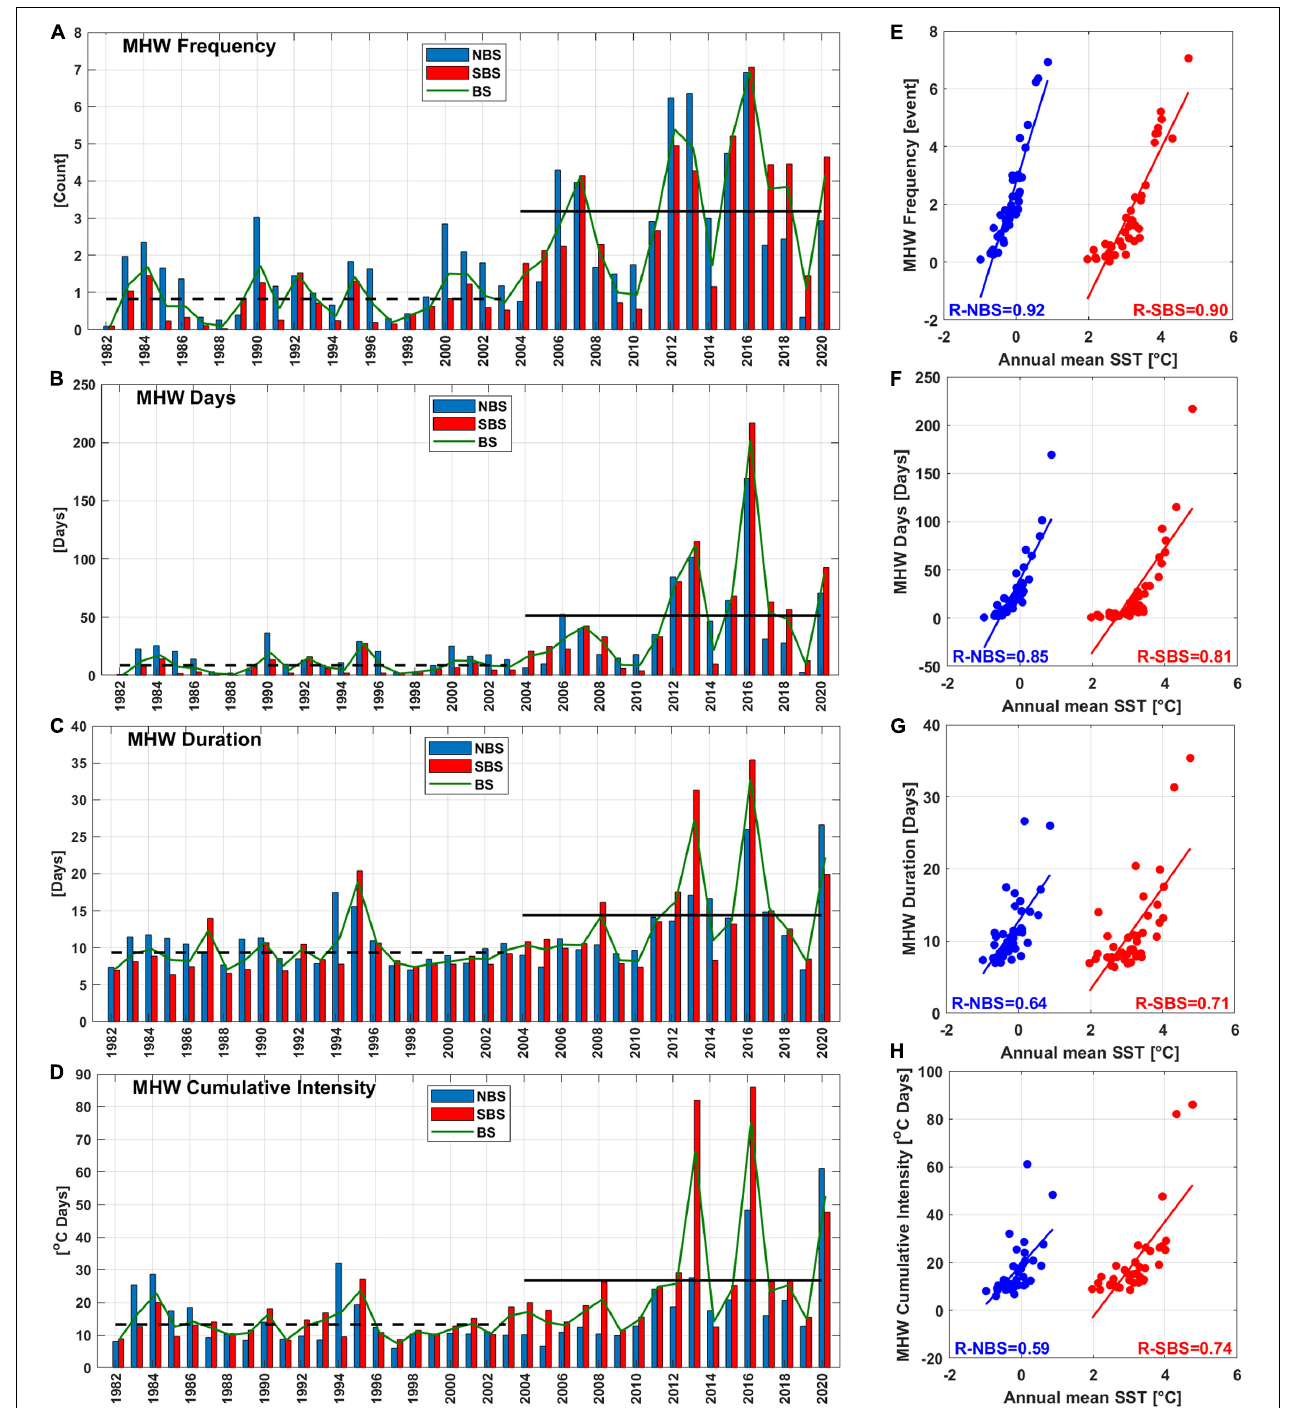
FIGURE 6 | Regionally averaged annual means of the MHW (A) frequency (events/year), (B) days (days/year), (C) duration (days/year), and (D) cumulative intensity ( ◦ C days/year). The blue and red bars represent the northern and southern Barents Sea (NSB and SBS), respectively. The green lines represent the whole Barents Sea (BS). The black dashed and solid lines represent the mean value for the whole BS over the pre- and post-2004 period, respectively. The right panels show the scatter plots of annual mean SST versus annual mean MHW (E) frequency, (F) days, (G) duration, and (H) cumulative intensity over NBS (blue) and SBS (red) from 1982 to 2020, with the blue and red lines representing the best-fit linear